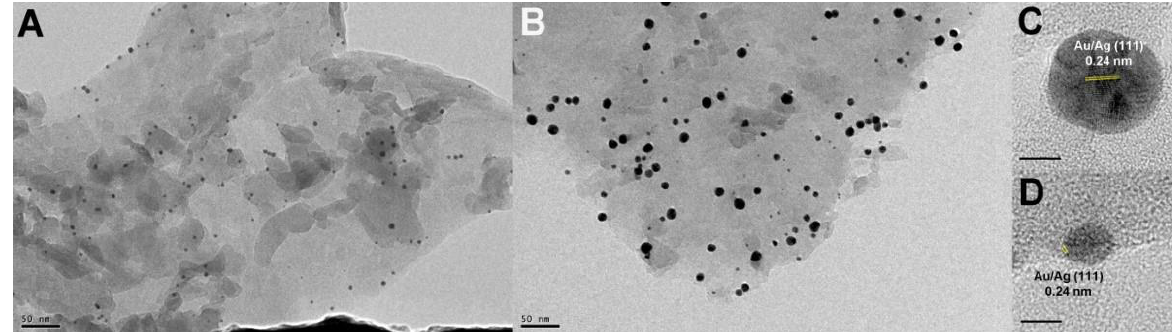
Figure 1. TEM images of AuAg-g-C 3 N 4 nanohybrid 2 ( A ) and 3 ( B ). HRTEM images for ca. 10 nm size NPs in 3 (bar corresponds to 5 nm) ( C ) and ca. 3 nm size NPs in 3 (bar corresponds to 5 nm) ( D ).